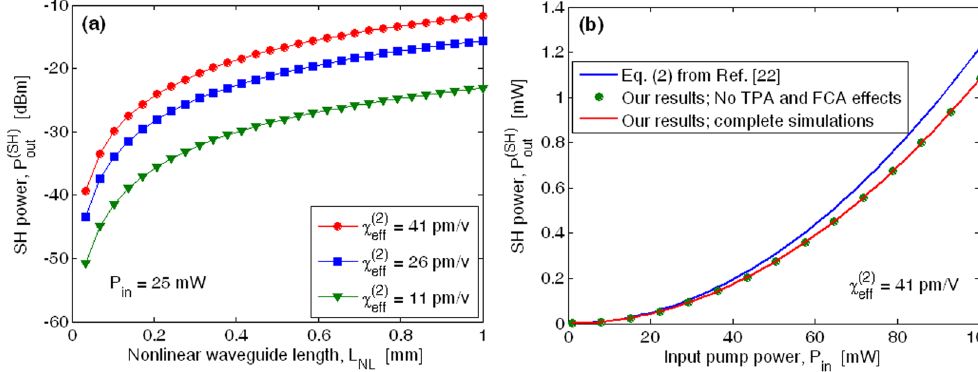
Figure 2. ( a ) SH power as a function of the nonlinear waveguide length for different values of the effective second order susceptibility. ( b ) SH power as a function of the input pump